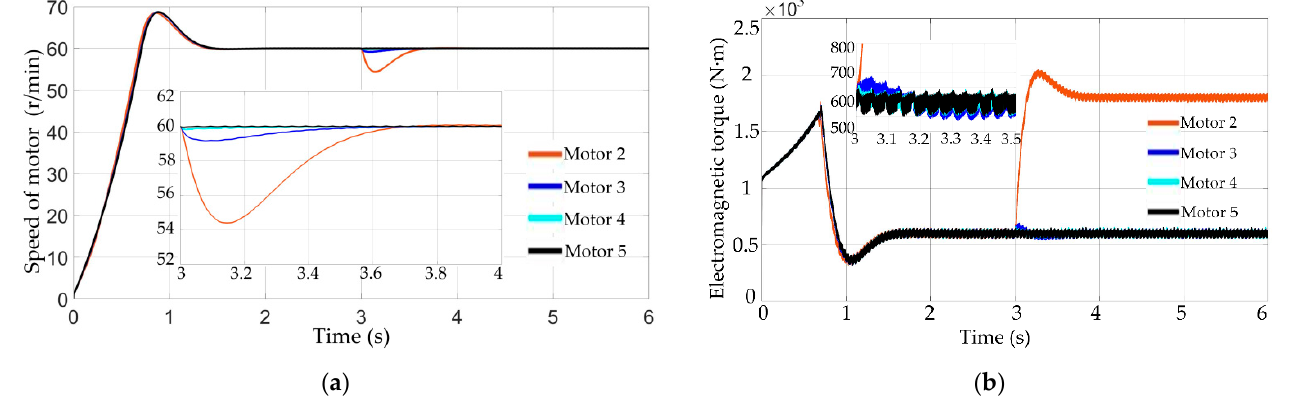
Figure 17. Response curve of roller motor of distributed permanent magnet direct-drive belt conveyor system under variable load operation conditions. ( a ) Speed curve; ( b ) Electromagnetic torque curve.